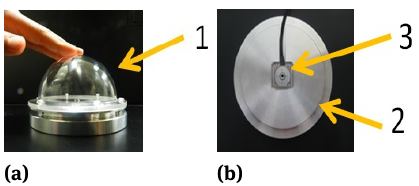
Fig. 4. The Touch Ball, used in the experiments; (a) The touch ball assembly; (b) The base plate and the three axis force sensor